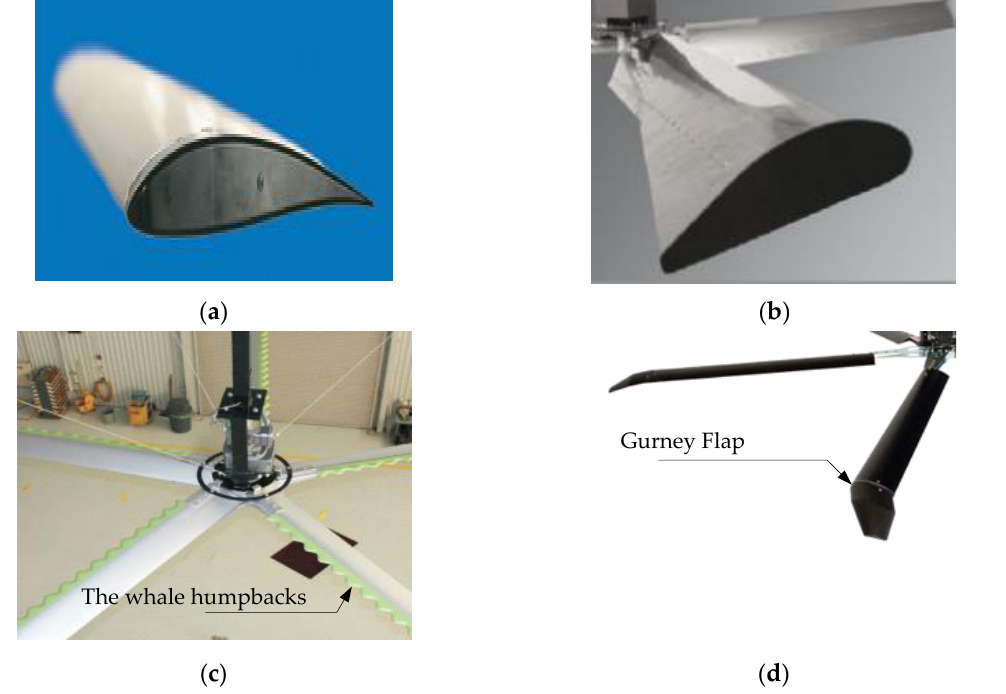
Figure 4. Other blade technologies ( a ) Whisper Foil XL Blade (Macro Air) ( b ) Complex contour shapes [15] ( c ) Tubercles fan blades [16] ( d ) Gurney flap.